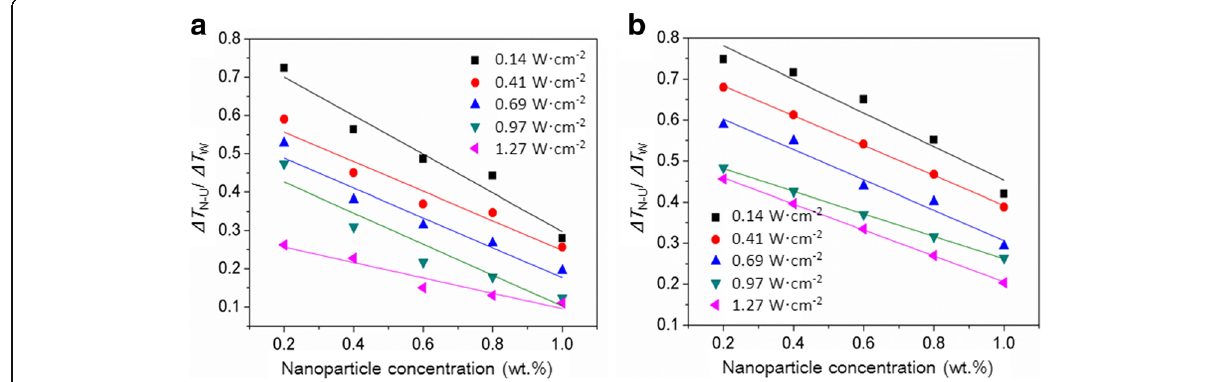
Fig. 4 Combined effect of ultrasound and nanoparticles on the supercooling degree of water [ a Al 2 O 3 nanoparticles, b SiO 2 nanoparticles]. Δ T Δ T N-U / W represents the ratio of supercooling degree required for the water solidification with nanoparticles and ultrasound to that without nanoparticles and